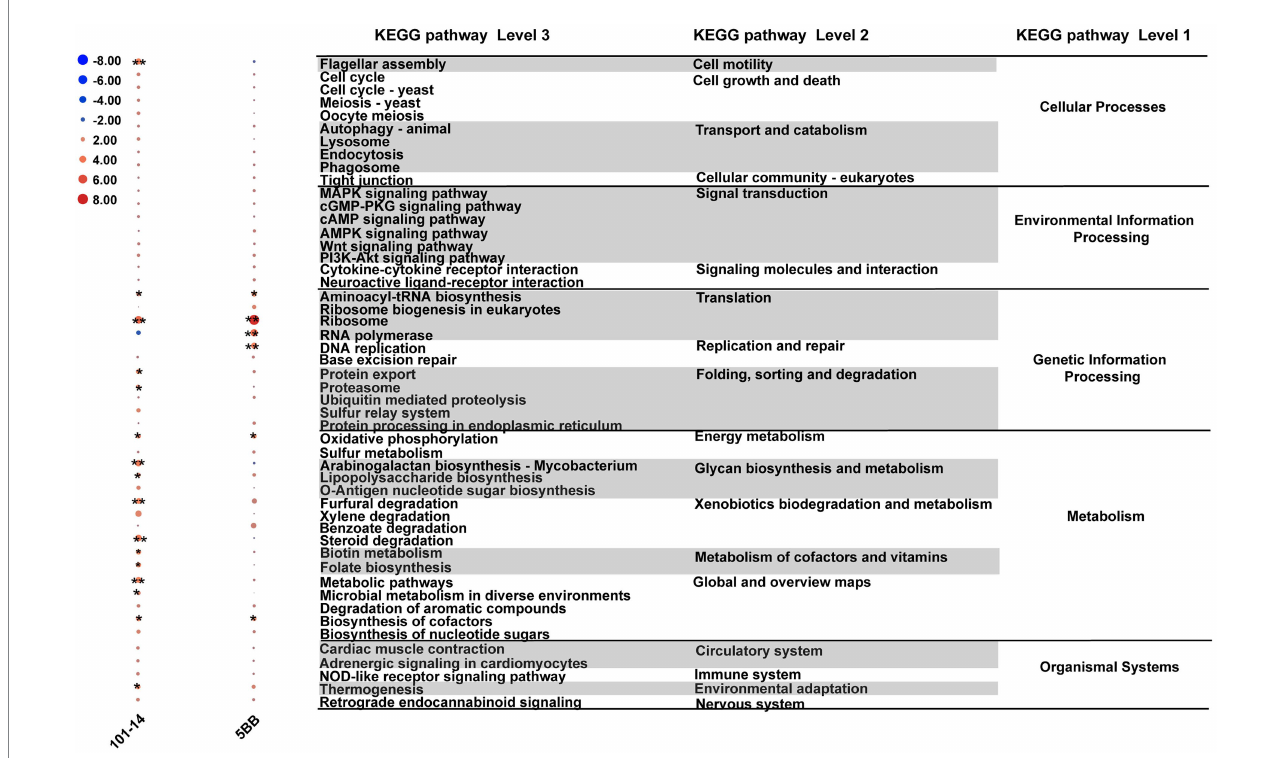
FIGURE 6 Heat map of top 50 KEGG pathways differentially enriched under salt stress in 101-14 and 5BB. Pathways are shown with a significant difference in reporter score. Blue, enriched in rhizosphere microbiota of both NaCl-treated varieties; red, enriched in rhizosphere microbiota of both ddH 2 O-treated varieties; green, enriched in rhizosphere microbiota of 101-14 treated with NaCl and ddH 2 O; orange, enriched in rhizosphere microbiota of 5BB in treated with NaCl and ddH 2 O. *denotes reporter score < − 1.96, or > 1.96. **represent reporter score < − 2.58, or >2.58. G1, 101-14 treated with NaCl; G2, 101-14 treated with ddH 2 O; G3, 5BB treated with NaCl; G4, 5BB treated with ddH 2